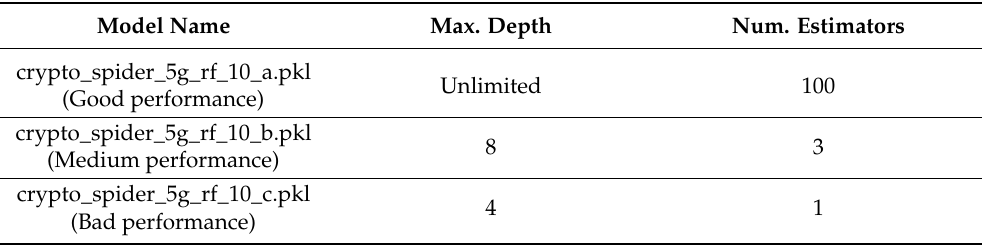
Table 2. Hyperparameters for each cryptomining Random Forest Classifier model